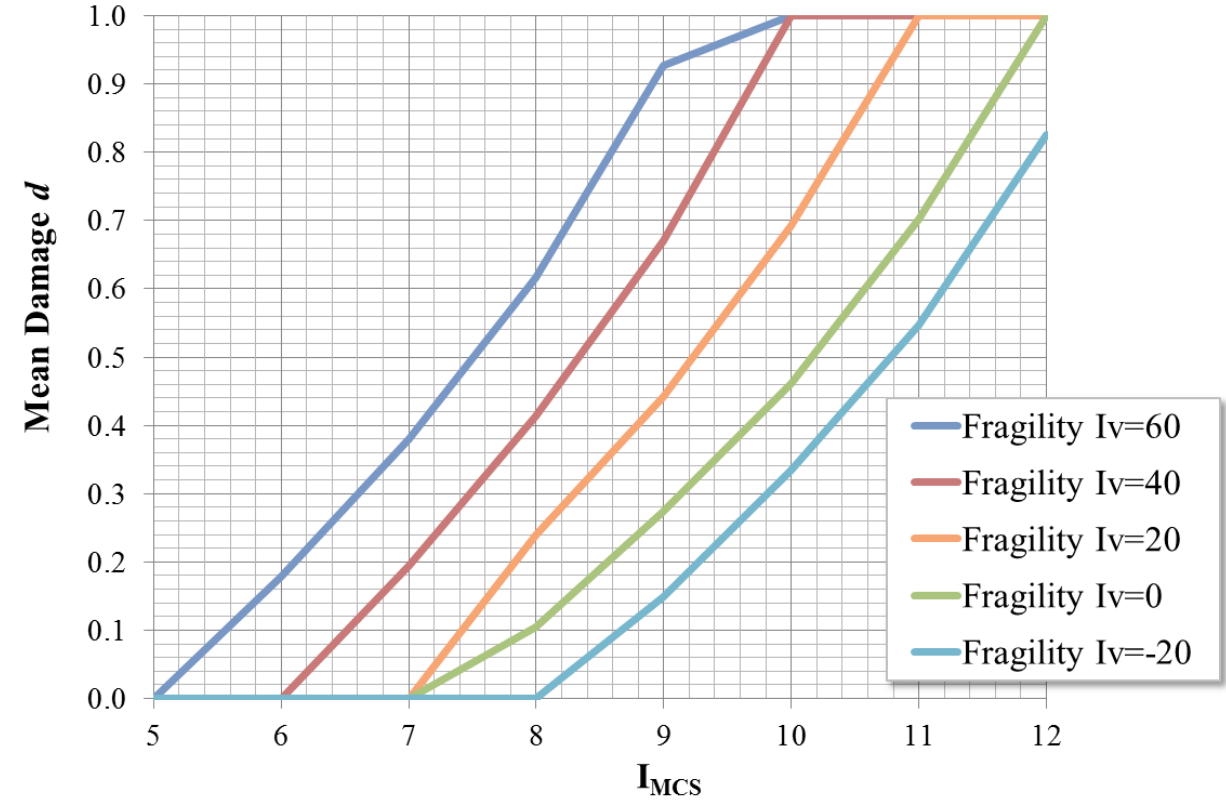
: relationship expressed in terms of V